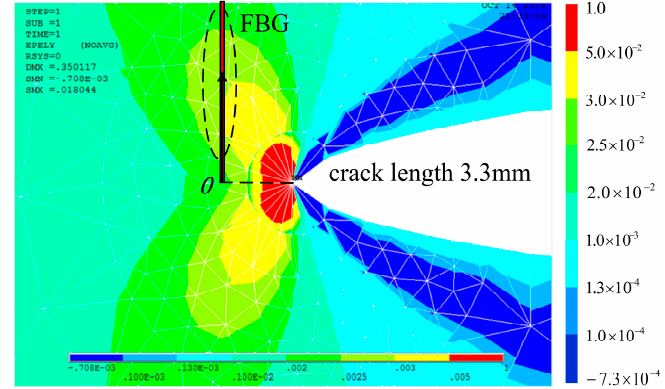
Figure 8. Finite element analysis of a crack with a length of 3.3 mm.